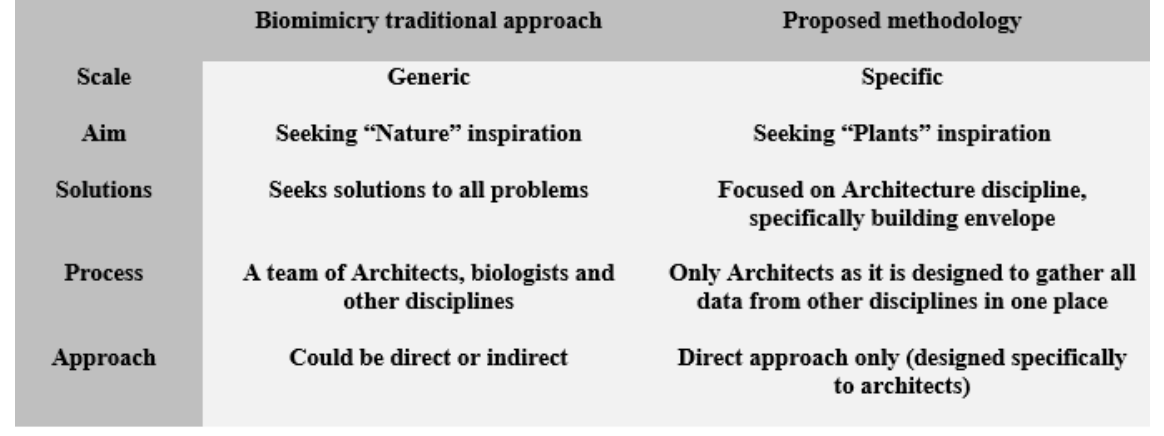
Figure 7: Showing the differences between Man-made constructions and nature’s strategies